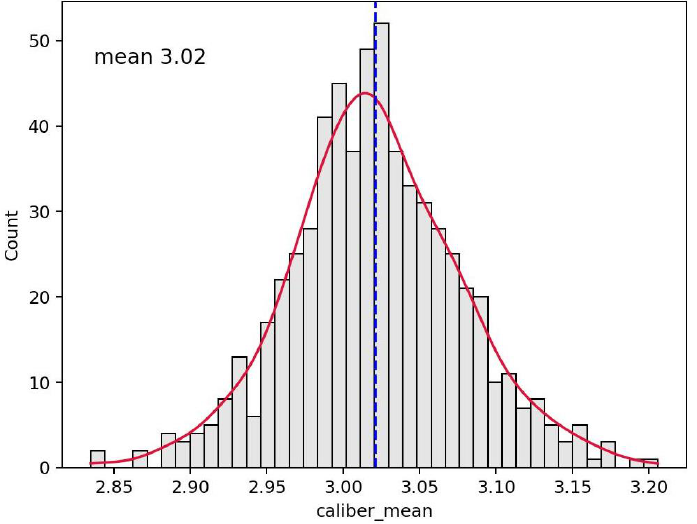
Figure 8. Histogram distribution of section gauge for the whole video. The dashed line indicates the mean value equal to 3.02 in this case.